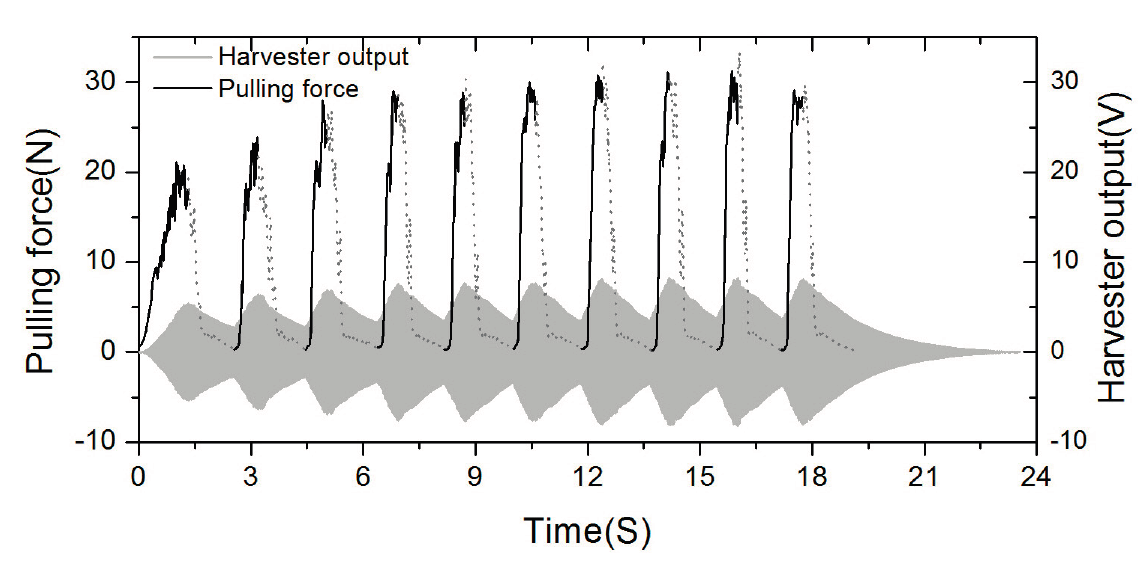
Figure 8. The recorded waveforms of pulling force and output